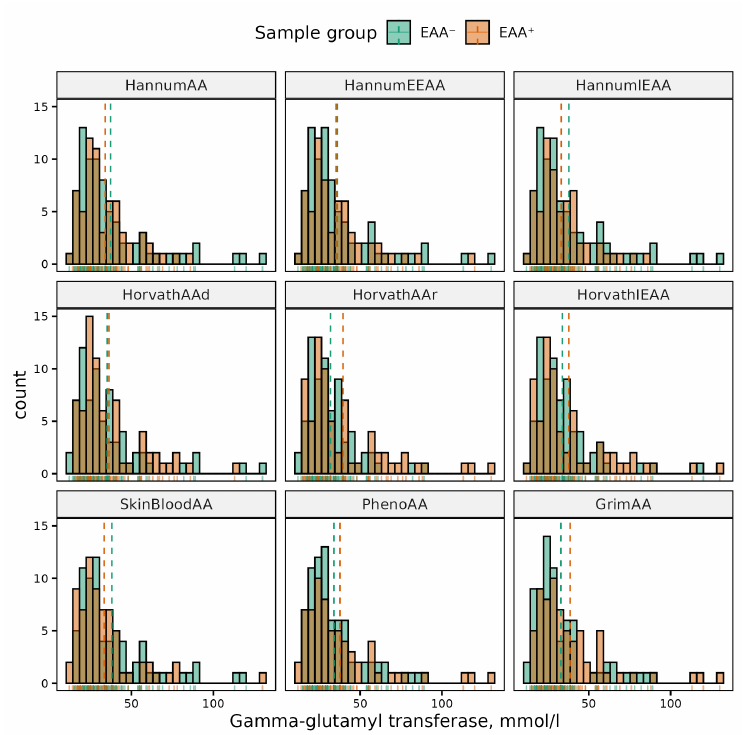
Figure A4. Histograms of distributions of GGT levels in males in EAA + and EAA − groups. Dashed lines correspond to the group